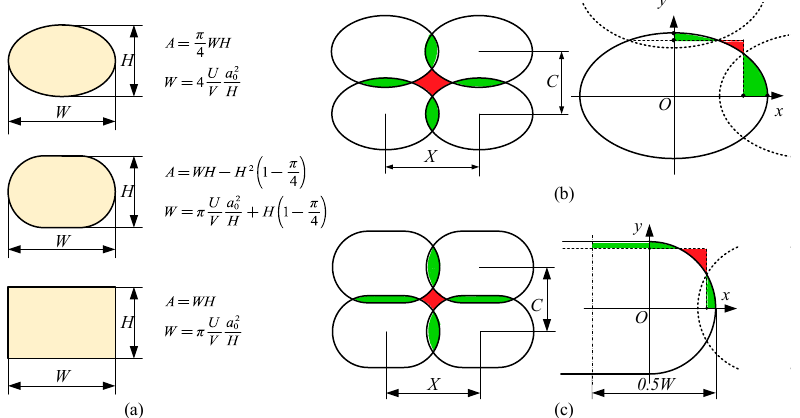
Figure 2. ( a ) Morphology of extruded strand cross-section, where 𝑊 is strand width, 𝐻 is strand height, 𝑉 is moving speed of nozzle, 𝑈 is the average velocity of the fluid passing through the nozzle cross-section, 𝐴 is cross-sectional area of strand, 𝑎 (cid:2868) is the inner radius of the nozzle tip, 𝑋 is spacing of strands, and 𝐶 is layer height. ( b ) No voids conditions for elliptical cross-section. ( c ) No voids conditions for rounded rectangle cross-section. The green part represents the overlap, and the red part represents the blank. Under certain conditions, the model can be used to predict the size of the strand width. The extrusion speed 𝑈 , moving speed 𝑉 , nozzle diameter 2𝑎 (cid:2868) , and nozzle height (theoretical layer height or the gap between nozzle tip and substrate) 𝛿 can be changed separately to adjust the width and height of the strand cross-section. Keeping the strand height 𝛿 = 𝐻 in order to get a linear strand width model, assuming the cross-section is